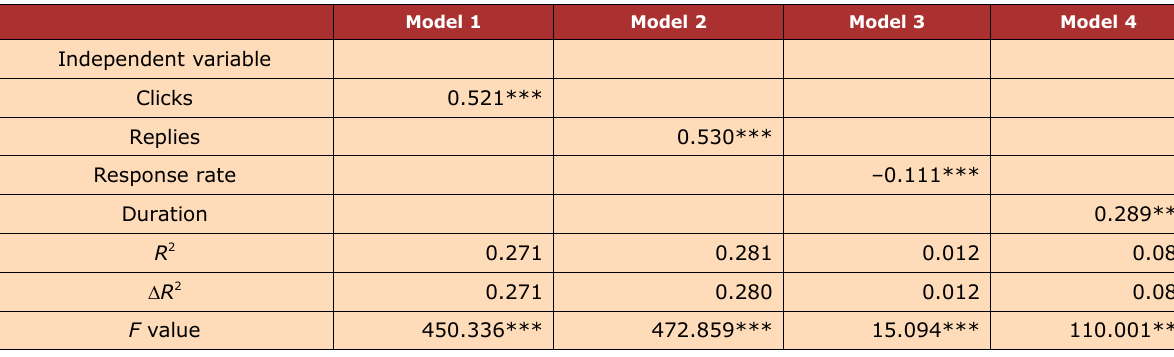
Table 8. Linear regression analysis of forum’s